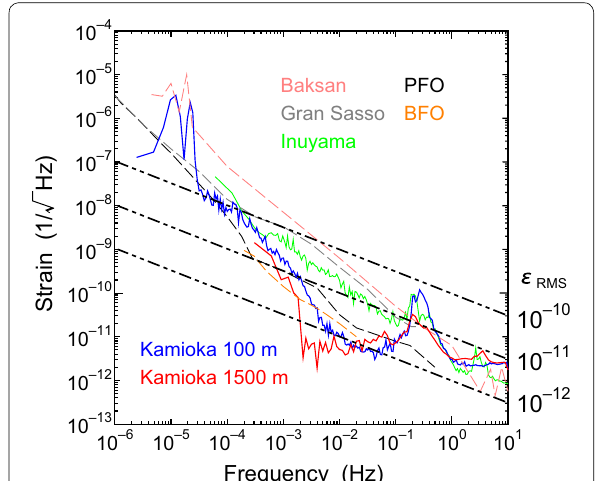
Fig. 5 Background strain spectrum for the 1500-m laser strainmeter ( red ) compared to those for other strainmeters: Piñon Flat Observa- tory (PFO, black , Berger and Lovberg 1970; Berger and Levine 1974), Baksan ( pink , Buklerskii et al. 1995), Gran Sasso ( gray , Crescentini and Renzella 1991), Inuyama ( green , Araya et al. 2001), and Black Forest Observatory (BFO, orange , Zürn et al. 2015), including the 100-m laser strainmeter at Kamioka ( blue , Araya et al. 2007). Detectable strain levels in amplitude are shown as dash - dotted lines . The detection limit for the 1500-m strainmeter is estimated as better than 10 − 12 in